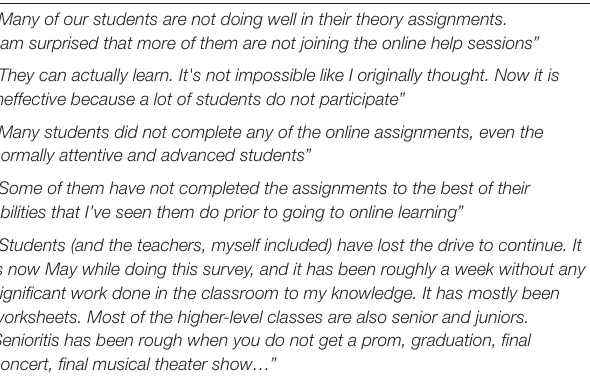
TABLE 1 | Participant comments regarding student